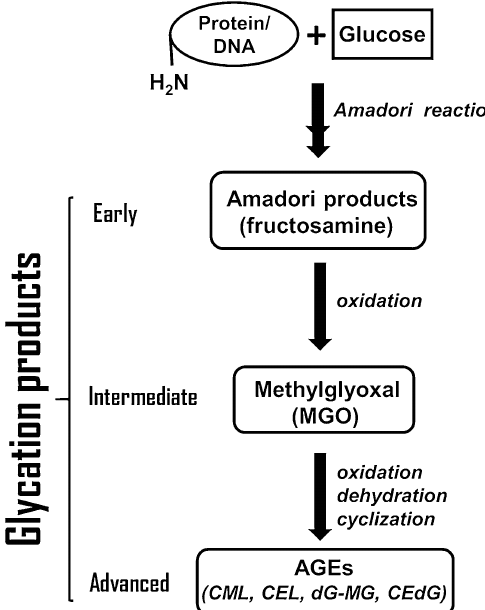
Figure 1. Key steps in glycation process. Reducing sugars interact with amino groups of protein or nucleic acids to form unstable Schiff bases that undergo intramolecular rearrangement to form Amadori products (early glycation products) such as fructosamine. These products are converted to reactive dicarbonyl compounds (intermediate glycation products) such as methylglyoxal (MGO), glyoxal, and 3-deoxyglucosone that are then irreversibly converted into advanced glycation products (AGEs). All the reactions are spontaneous (not enzymatically catalyzed). Further details are provided in refs 10, 14, and 46. Examples of AGE adducts to proteins and DNA: CML: Nε-(carboxymethyl)-lysine; CEL: Nε-(carboxyethyl)-L-lysine; CEdG: N2-(1- carboxyethyl)-deoxyguanosine; dG-MG: 3-(2 ′ -deoxyribosyl)-6,7-dihydro-6,7-dihydroxy-6-methylimidazo-